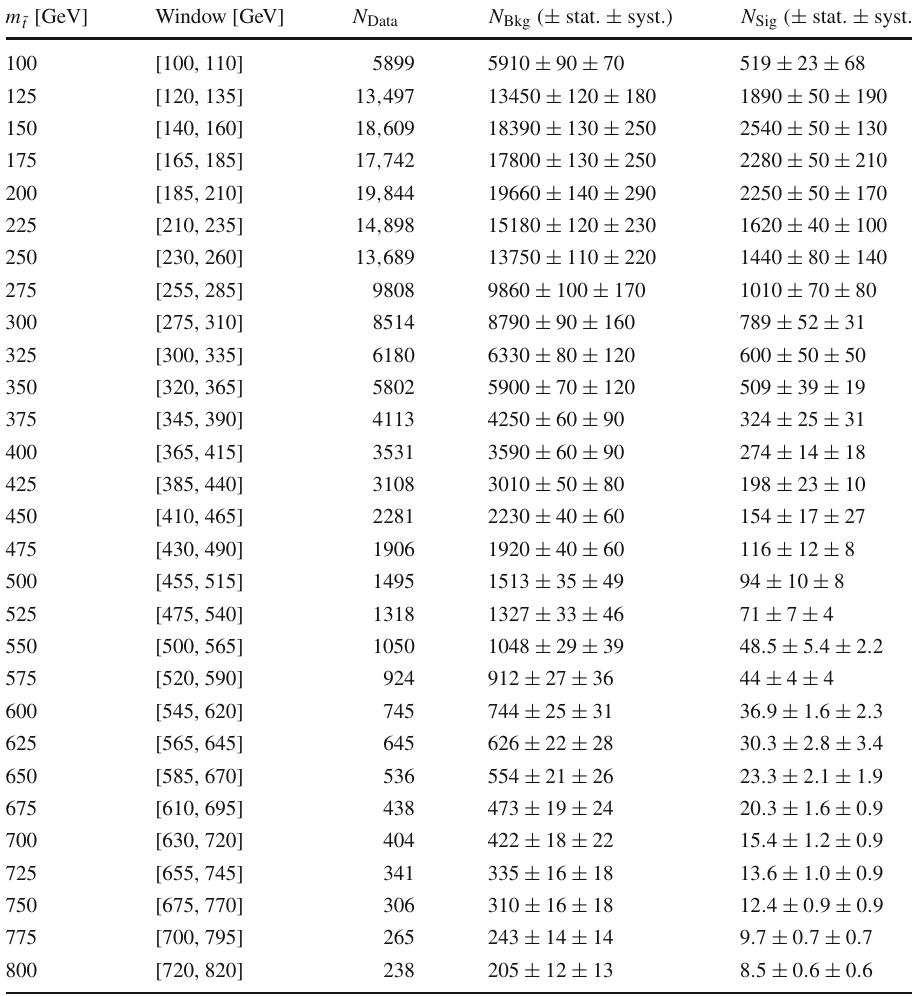
Fig. 8 The m avg spectrum in the inclusive (left) and b -tagged (right) signal regions. The data (black points) are compared to the total back- ground prediction (red line) estimated with the data-driven method. The fraction of background coming from top-pair production is shown in